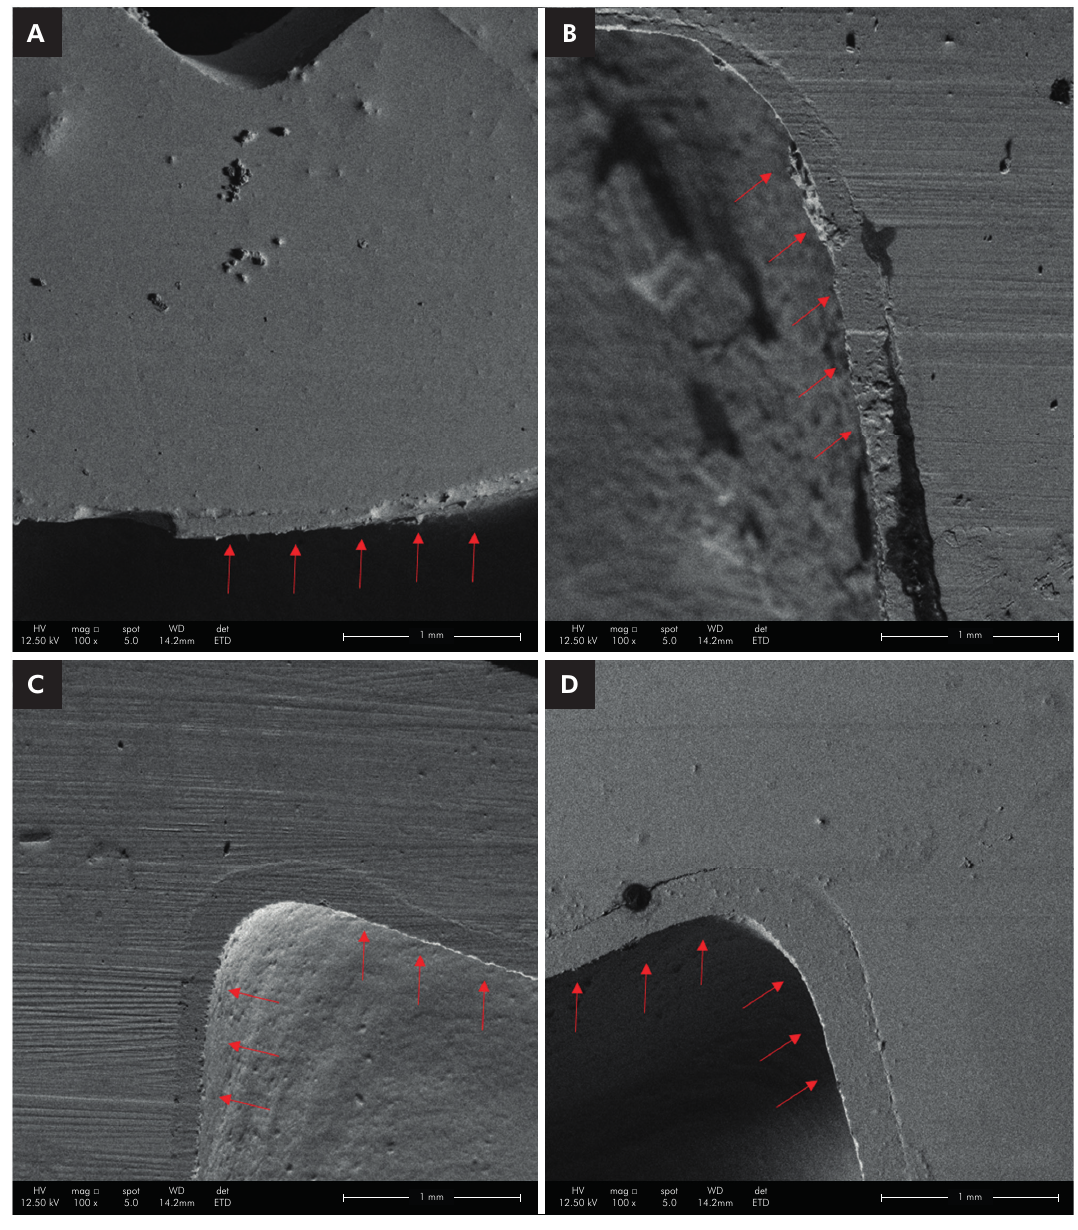
Figure 4. Micrographs showing the presence of cement on the inner surface of the Y-TZP crowns (indicated by arrows), which characterizes adhesive failures of the cement with the preparation on epoxy resin. Groups GP (A), GS (B), RS (C) and P (D).